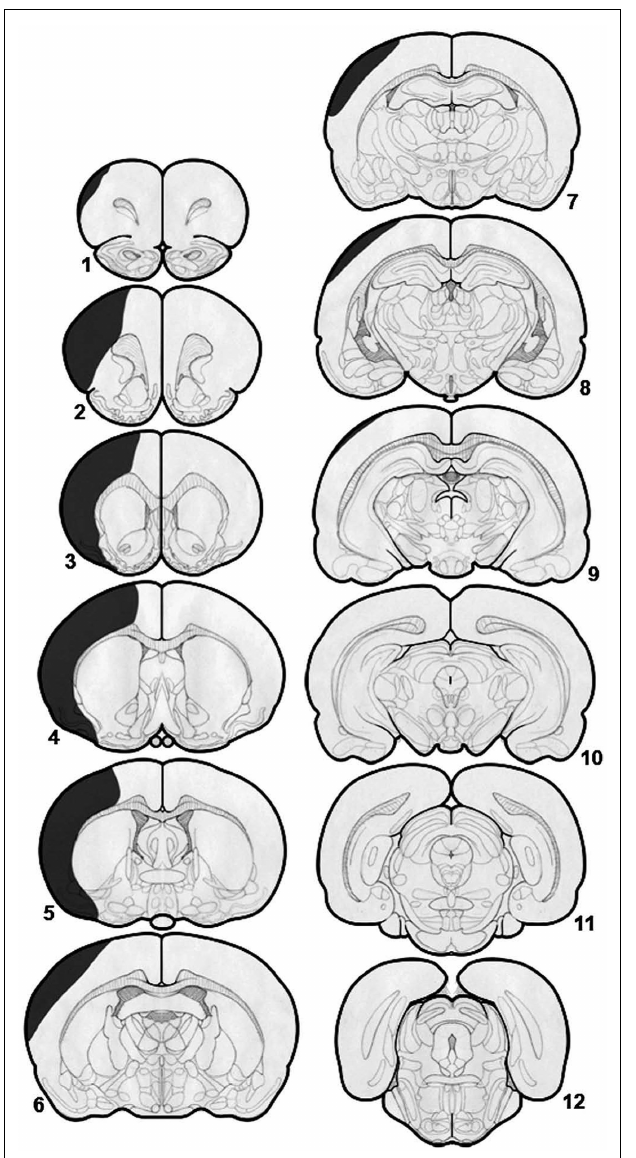
FIGURE 3 | Diagrammatic representation of a typical stroke associated with coagulation and division of the middle cerebral artery and 30-min occlusion–reperfusion of both common carotid arteries. There is significant damage to the cortex anterior to the bregma but relative sparing of the areas posterior to the bregma.There is almost total sparing of the basal ganglia and thalamus.With permission from Elsevier Limited